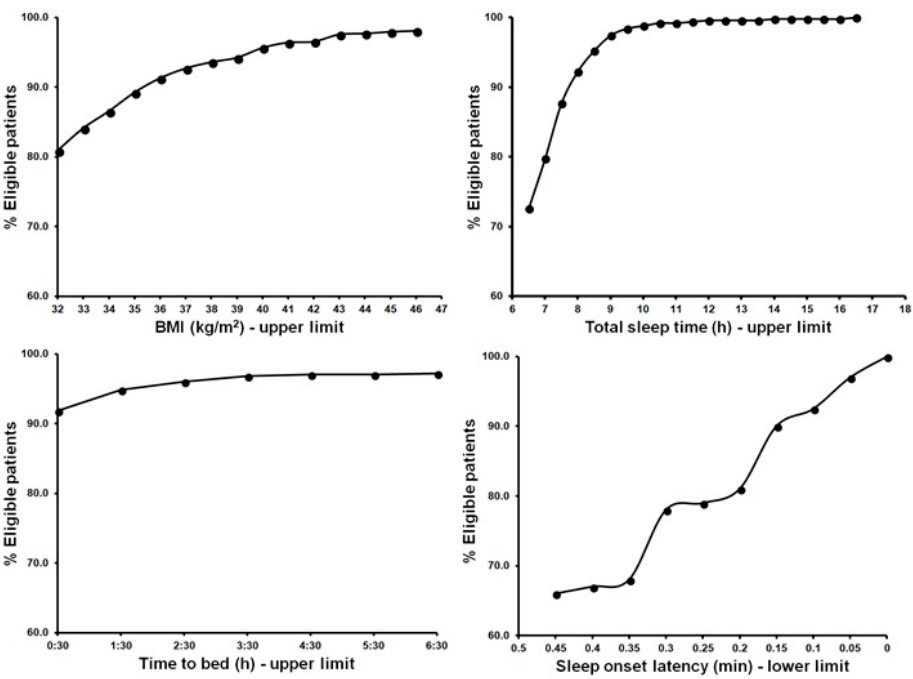
Figure 2. Percentage of eligible patients as an effect of changing an upper or lower criterion limit. BMI = body mass index.